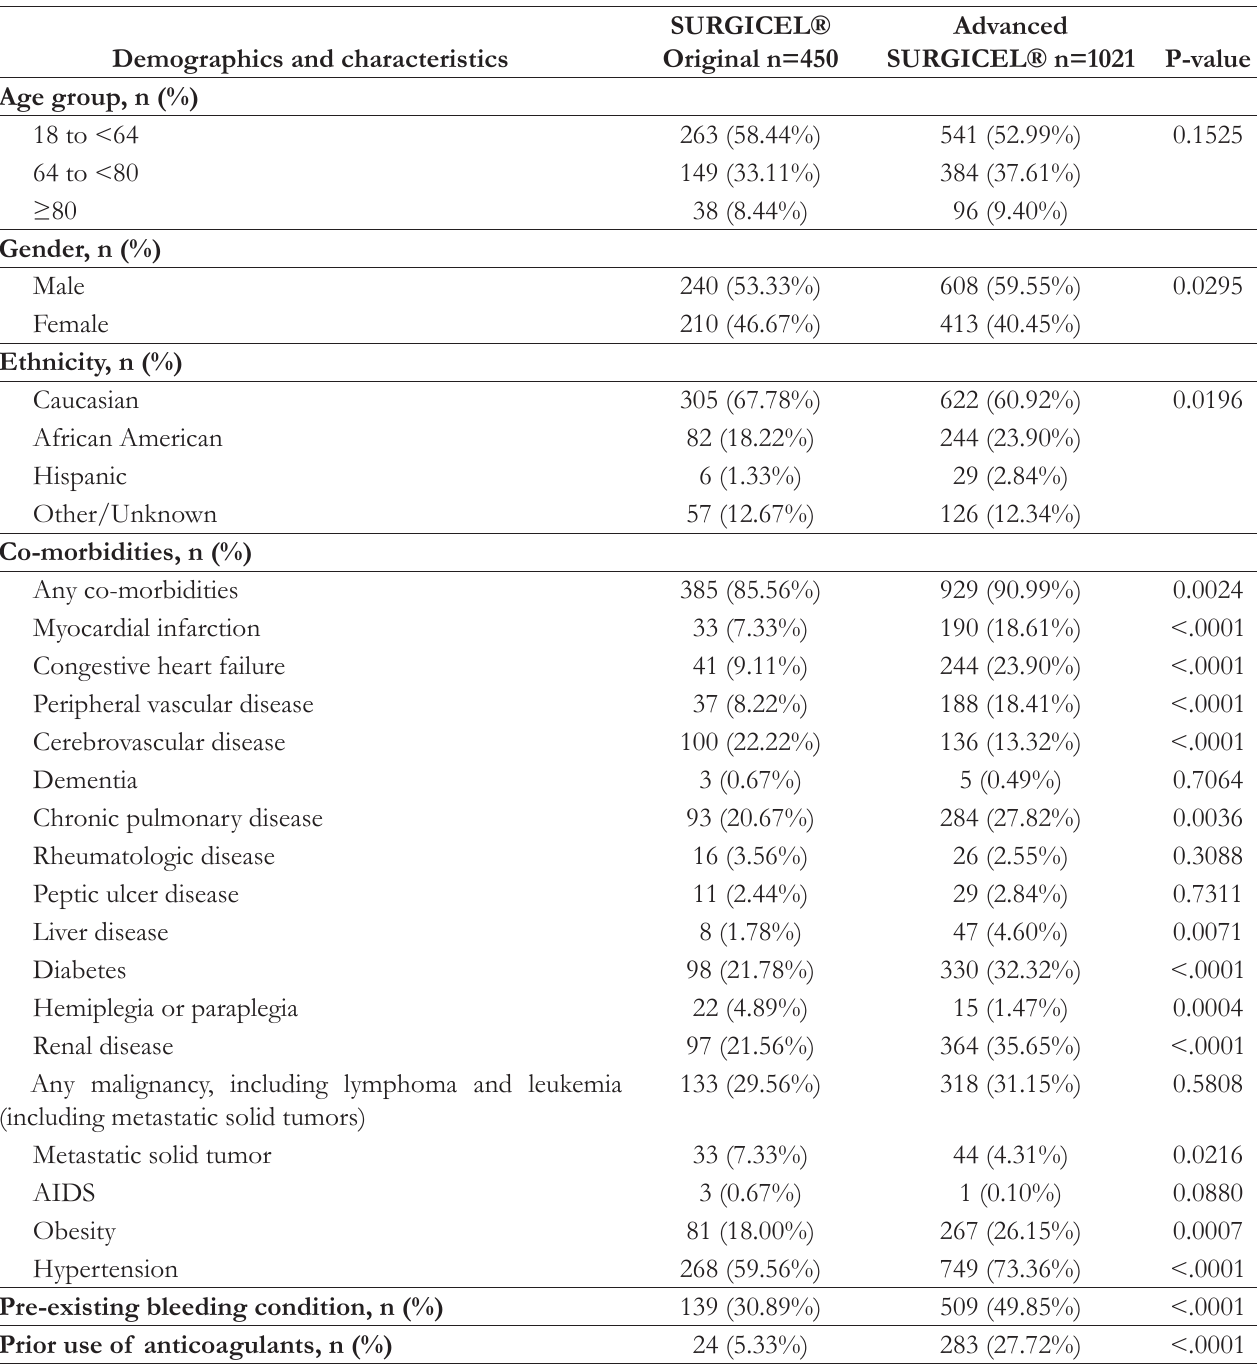
Table 1. Patient demographics and characteristics,